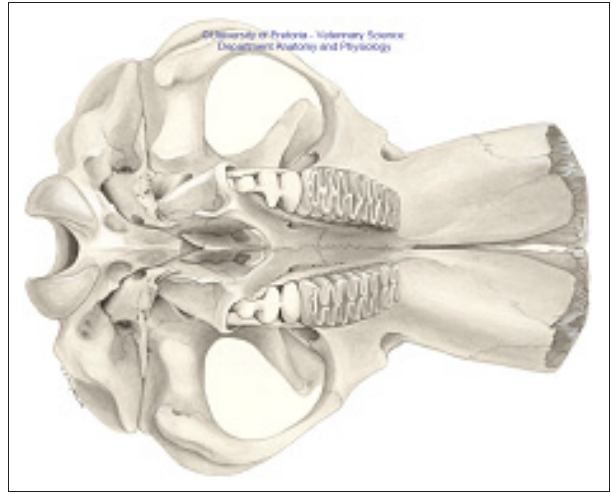
FIGURE 1: Anatomical representation of a ventral view of the adult elephant